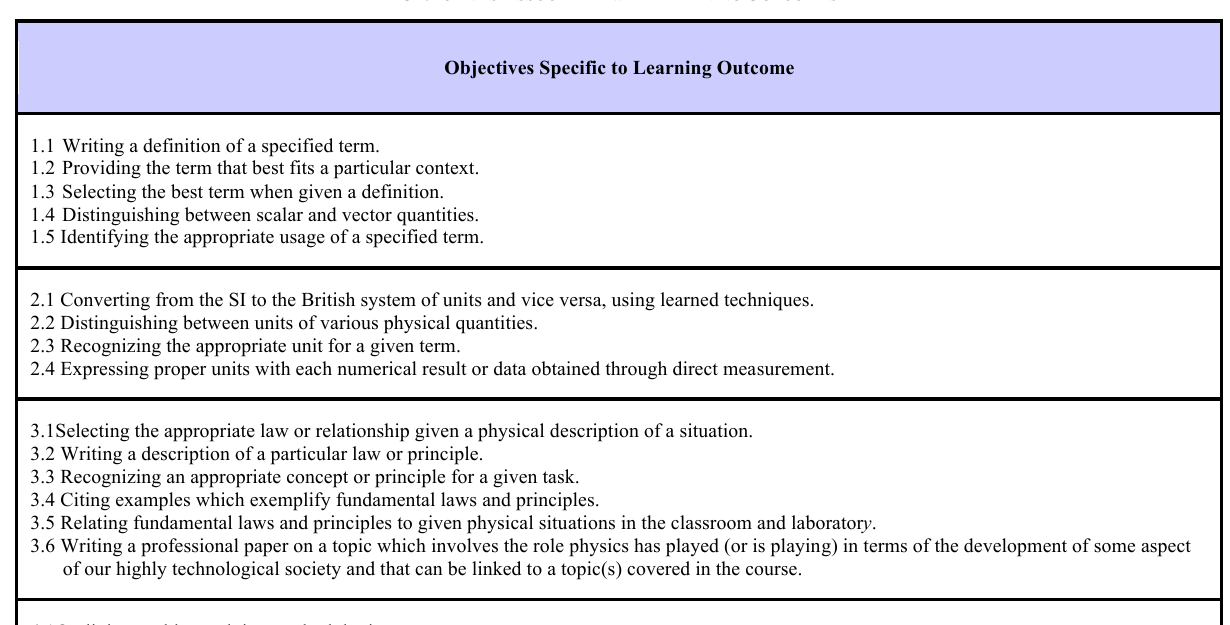
TABLE II. O BJECTIVES A SSOCIATED WITH L EARNING O UTCOMES